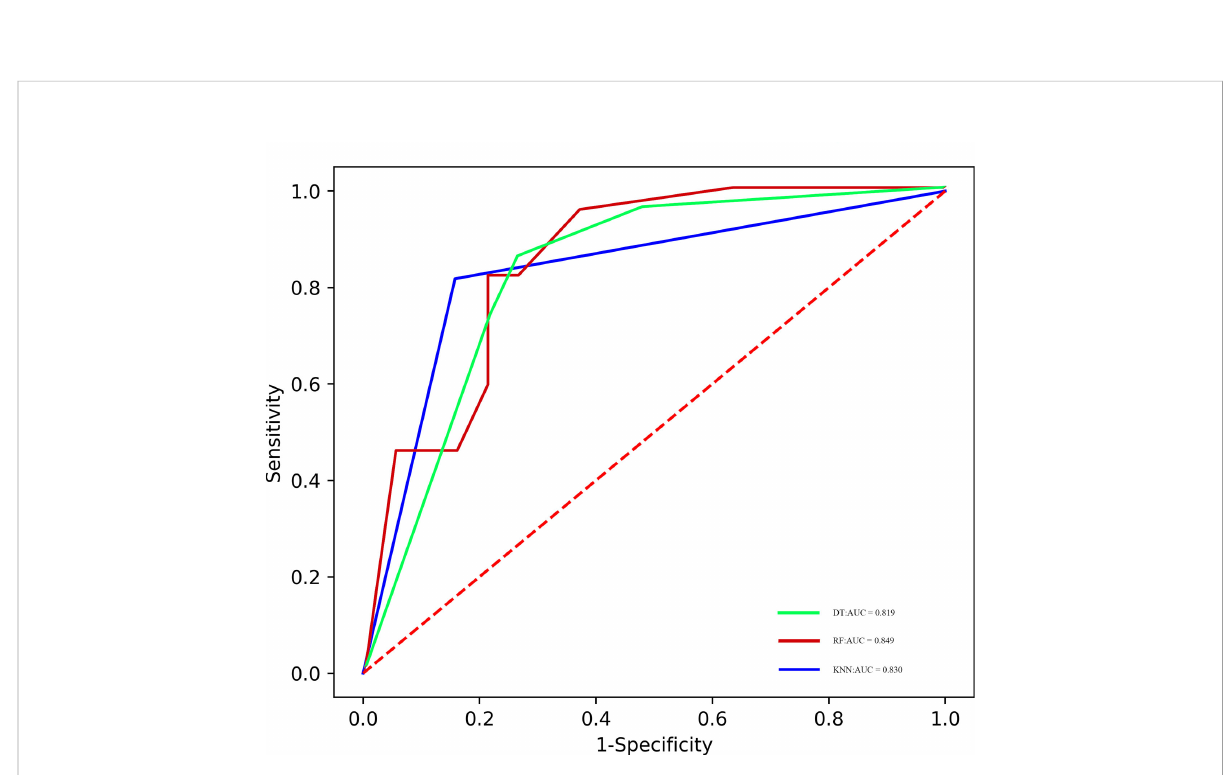
FIGURE 4 ROC of the different models in the validation cohort.